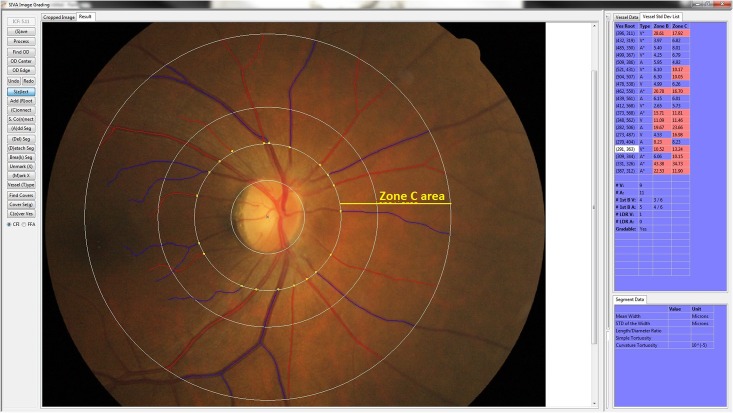
Image of SIVA grading platform.Retinal microvasculature assessment on the grading platform. A screenshot of a computer-assisted program for measurement of new geometrical retinal vascular parameters from retinal fundus photograph. Zone C is marked in SIVA software by 0.5 to 2.0 optic disc diameter away from the margin of optic disc, respectively. All retinal arterioles and venules larger than 25 μm are marked and assessed within zone C.